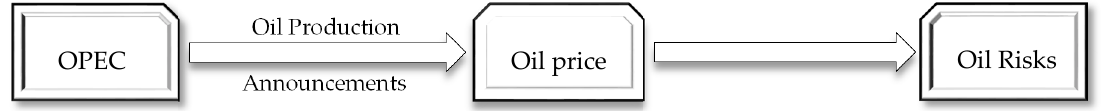
Figure 1. The logical relations among oil price reactions and oil risk reactions to OPEC’s